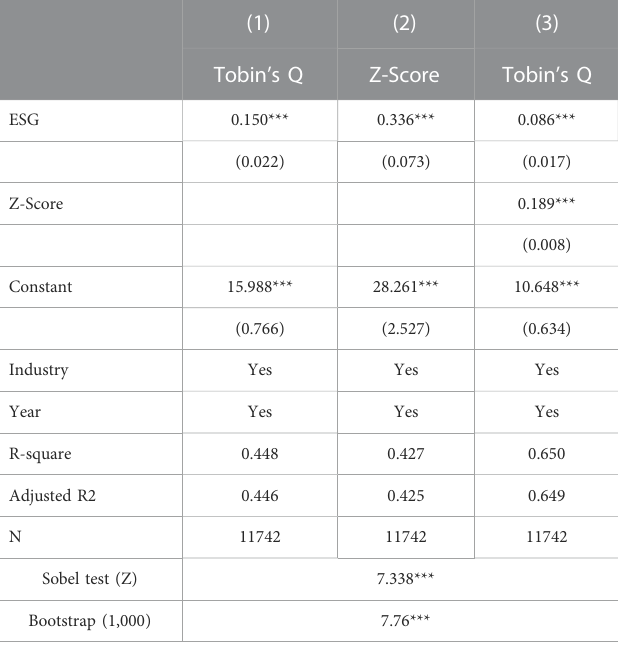
TABLE 8 The mediation effect of corporate fi nancial